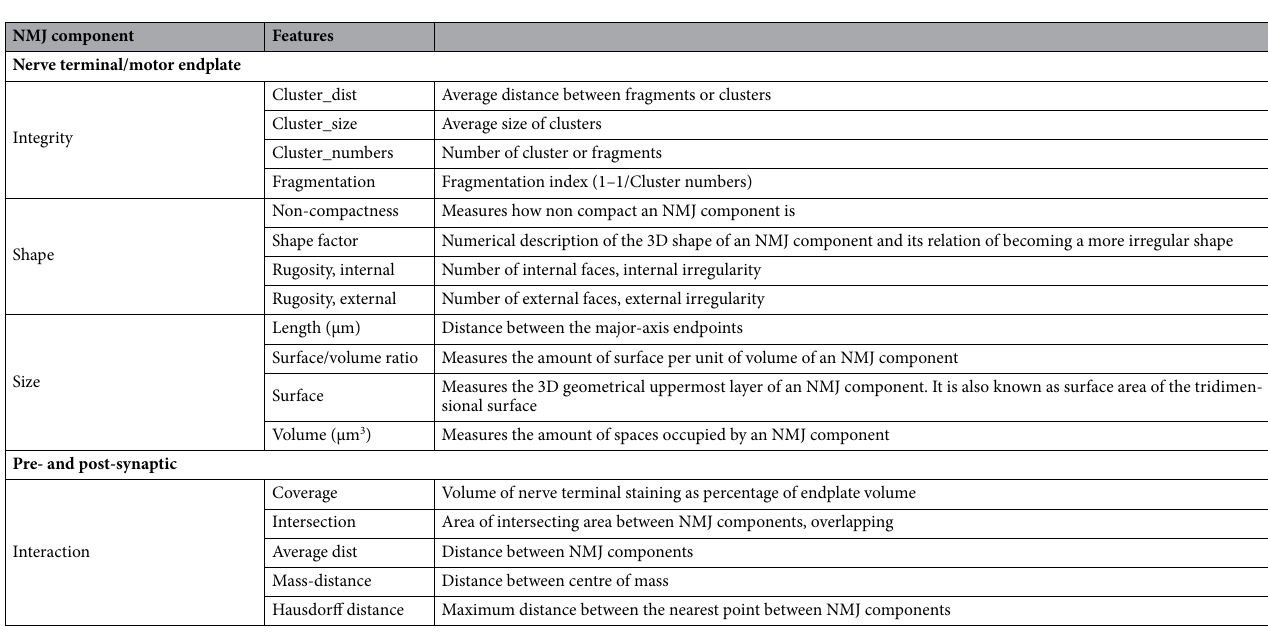
Table 2. Overview of NMJ morphological